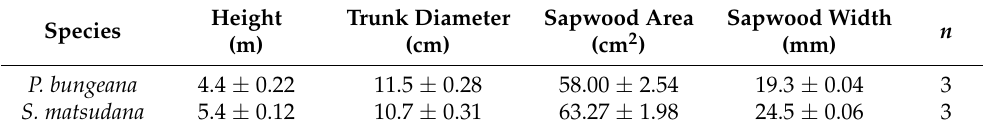
Table 1. Experimental tree details. Note: n is the number of